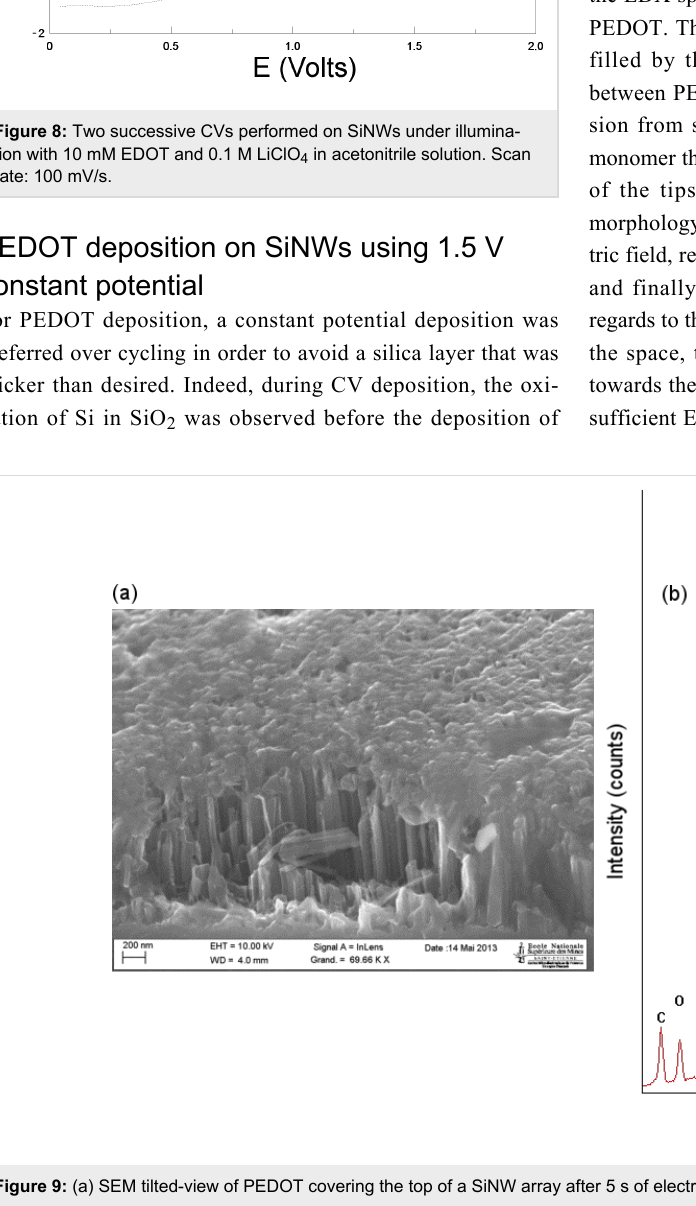
Figure 8: Two successive CVs performed on SiNWs under illumina- tion with 10 mM EDOT and 0.1 M LiClO 4 in acetonitrile solution. Scan rate: 100